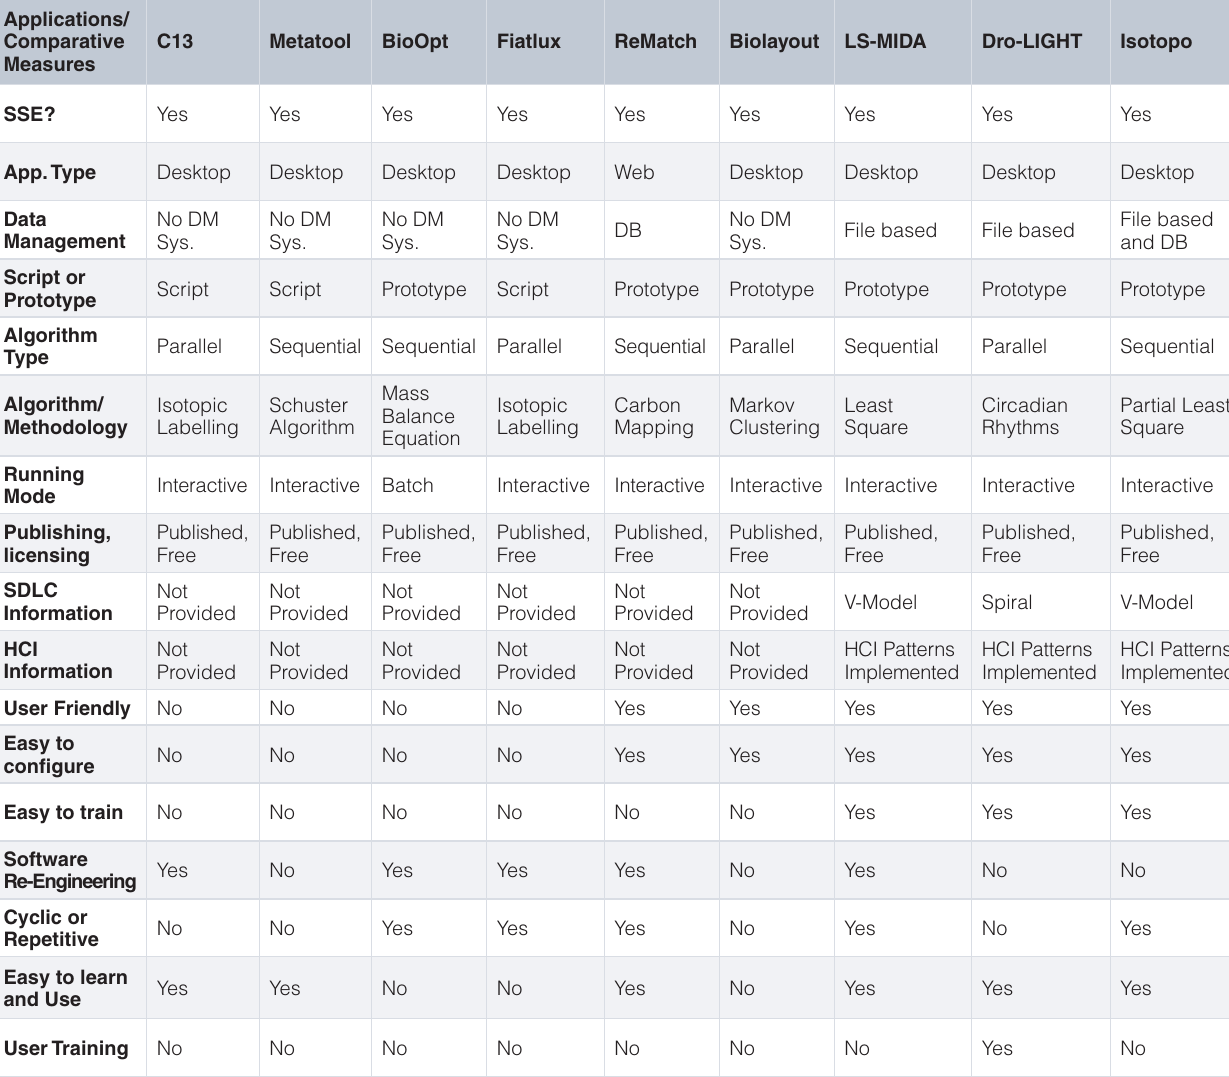
Table 2. Comparative analysis of different scientific software applications. SSE=Scientific Software Application; App.=Application; DB=Database; DM=Data Management; Sys.=System; SDLC=Software Development Life Cycle. Applications/